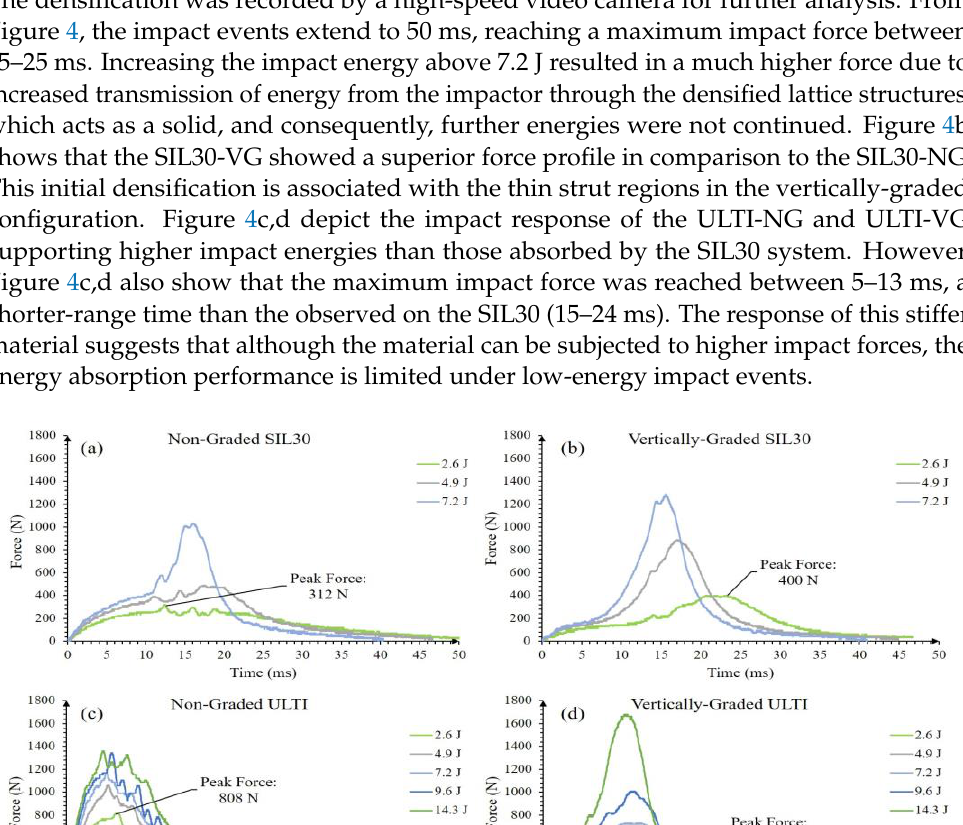
Figure 5. Force versus displacement of SIL30 and ULTI at different impact energies; ( a ) SIL30-NG, ( b ) SIL30-VG, ( c ) ULTI-NG, ( d ) ULTI-VG. Densification points are labeled; however, ULTI-NG does not show densification in these graphs due to its stiffness.